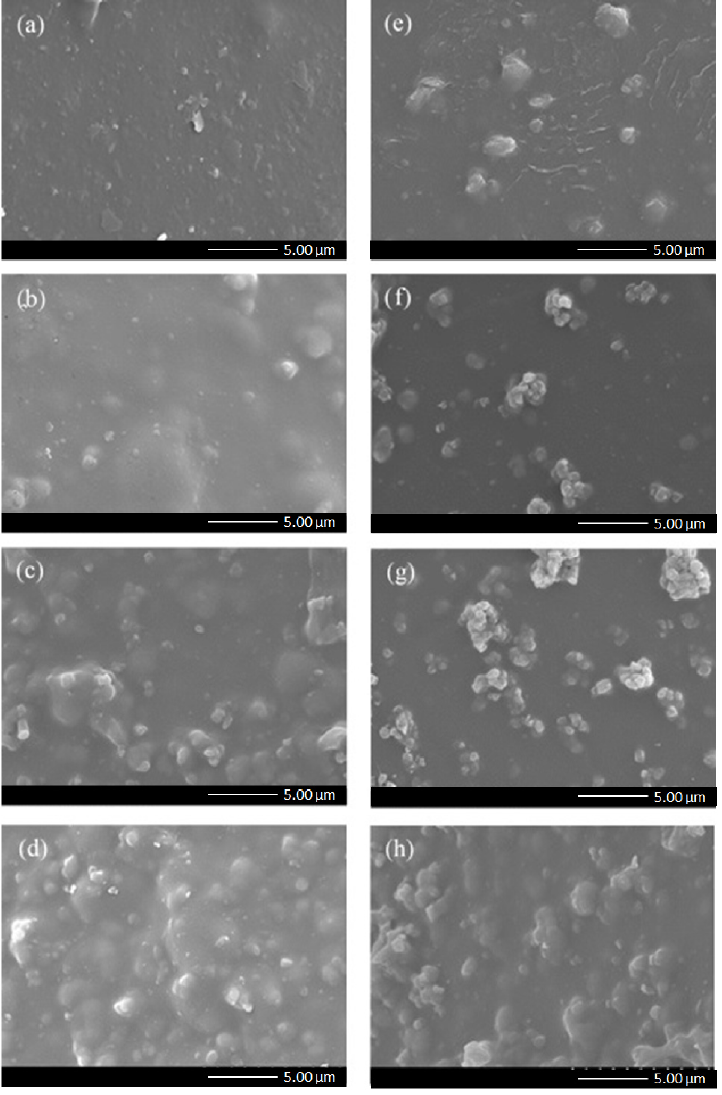
Figure 5. Top view of MMMs incorporated with ( a ) 5, ( b ) 10, ( c ) 15, and ( d ) 20 wt.% of ZeY, respectively, and with ( e ) 5, ( f ) 10, ( g ) 15, and ( h ) 20 wt.% of Mo-ZeY, respectively. In Figure 6, the ATR-FTIR spectra of the PSF hollow fiber support, pristine Pebax, PSF/Pebax composite membrane, and PSF/Pebax with 20 wt.% ZeY/Mo-ZeY MMMs are shown. This is to verify several functional groups of the prepared membranes and their components. Three prominent peaks of PSF were observed at 1584, 1236, and 1147 cm − 1 corresponding to C=C conjugation in the aromatic ring, C-O between aromatic rings, and S=O symmetric in a sulfonate group, respectively [26]. Further, several major stretching vibrations in the Pebax membrane were observed at 3300–3400, 1638, 1541, and 1731 cm − 1 indicating secondary amine (=N-H) and N-H region, amide bonding (-CONH), carbonyl group (C=O) in polyamide (PA) section, and carbonyl group (C-O) in polyethylene oxide (PEO) section, respectively